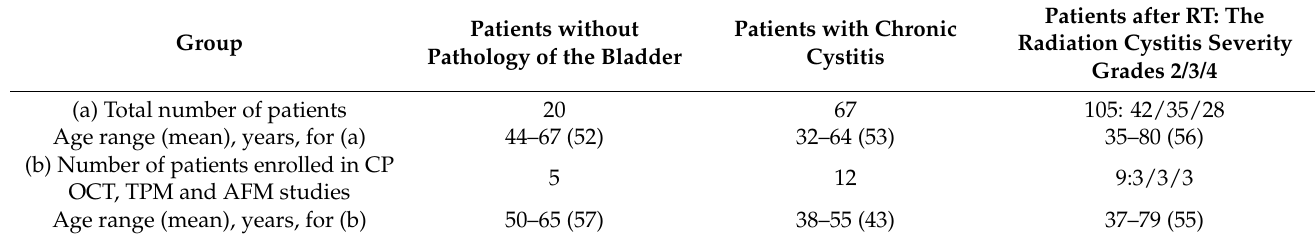
Table 1. Data of the patients included in the